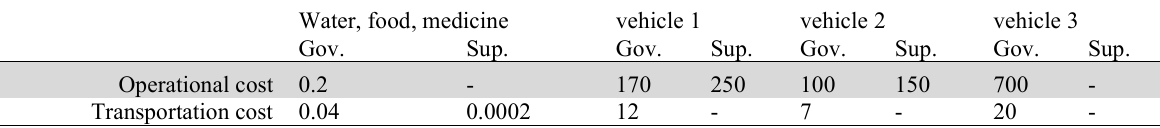
Unit of transportation and operation costs of the government and international suppliers for distribution and